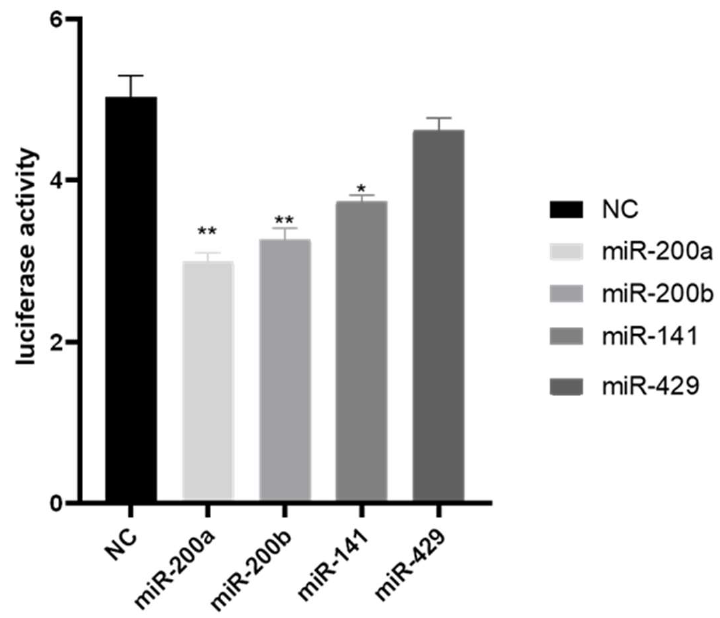
Figure 3. The luciferase activity of wild recombinant reporter plasmid. * Indicates a statistically significant difference ( p < 0.05); ** Indicates a very statistically significant difference ( p < 0.01). To clarify whether miR-200a and miR-200b interacted with amh through site 1 or